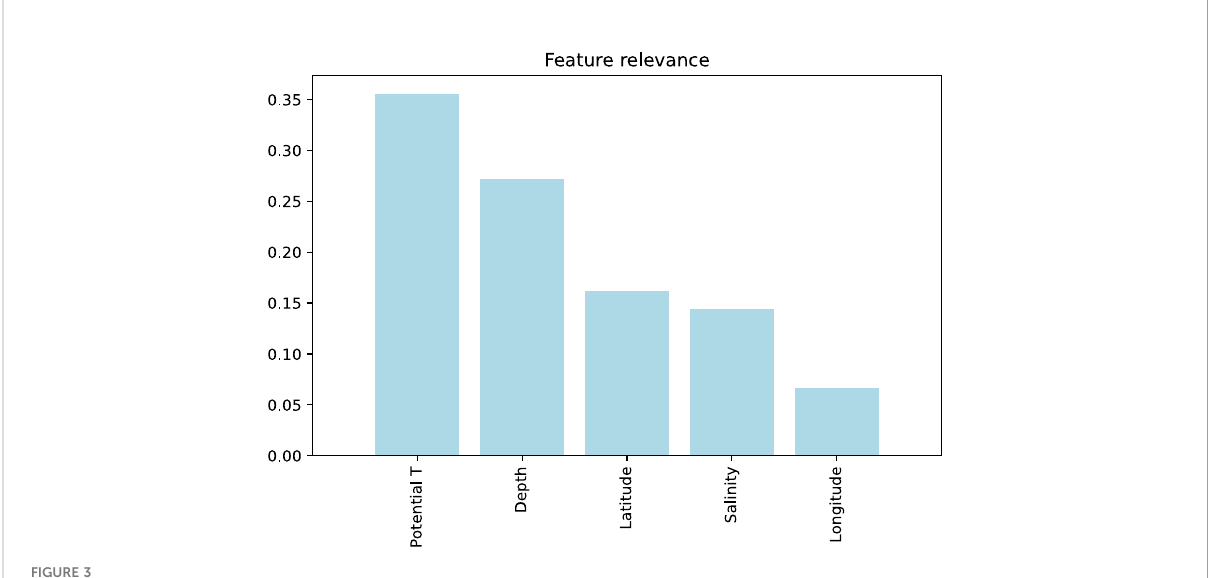
FIGURE 3 Feature relevance for the Extremely Randomized Trees regression model.